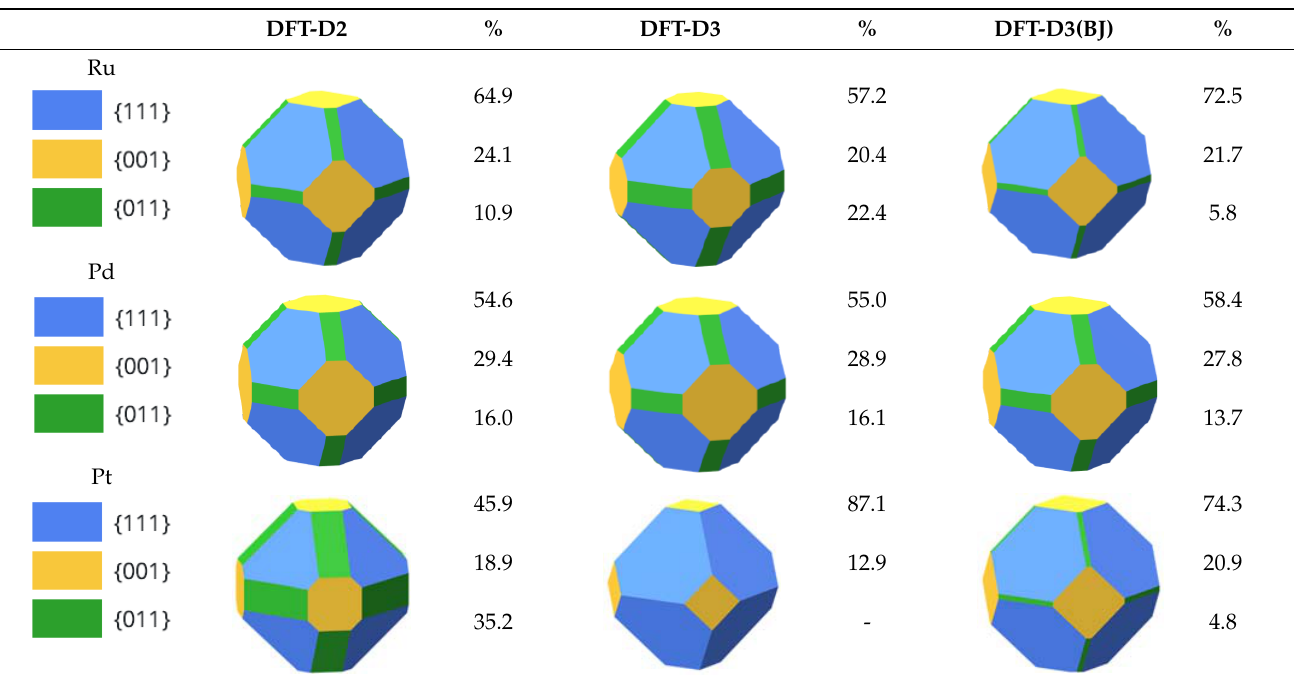
Table 2. Wulff morphologies constructed from surface energy for the DFT-D2, DFT-D3 and DFT- D3(BJ) method for Ru, Pd and Pt.